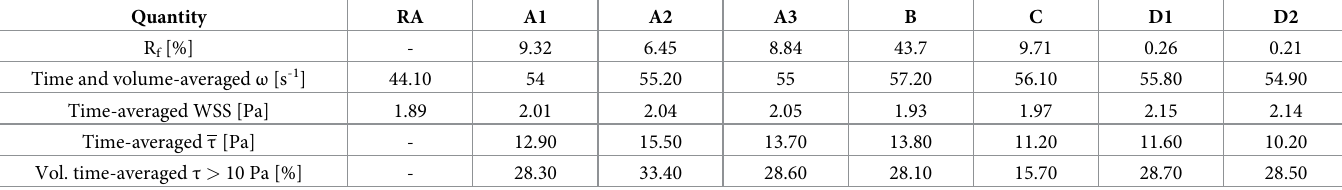
Table 7. Haemodynamic predictions for all catheter models.